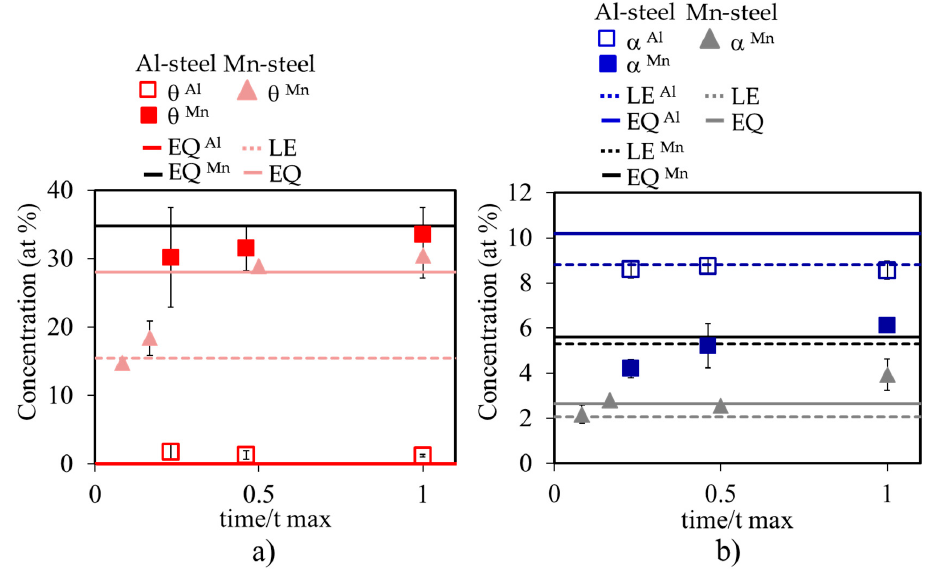
Figure 6. ( a ) Mn and Al concentrations (solid and hollow squares, respectively) for the Al-steel and Mn concentration (triangles) for the Mn-steel in cementite and ( b ) in ferrite during different holding times at 670 °C. Theoretical values predicted by Thermo-Calc are also represented: solid lines are the equilibrium values for Al and Mn in cementite and in ferrite. LE values are given by the dotted lines.